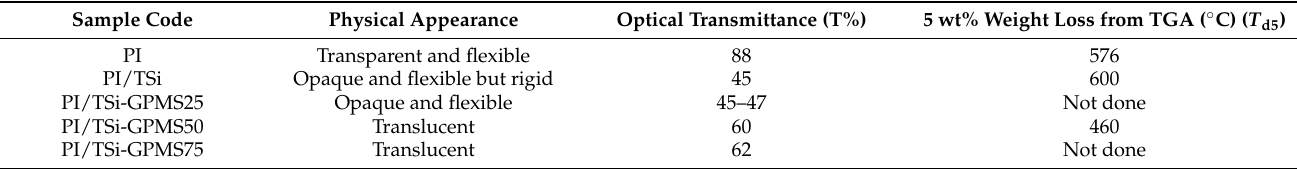
Table 1. Physical, optical transmittance, and the relevant TGA temperature that triggered 5 wt% weight loss of the samples. Sample